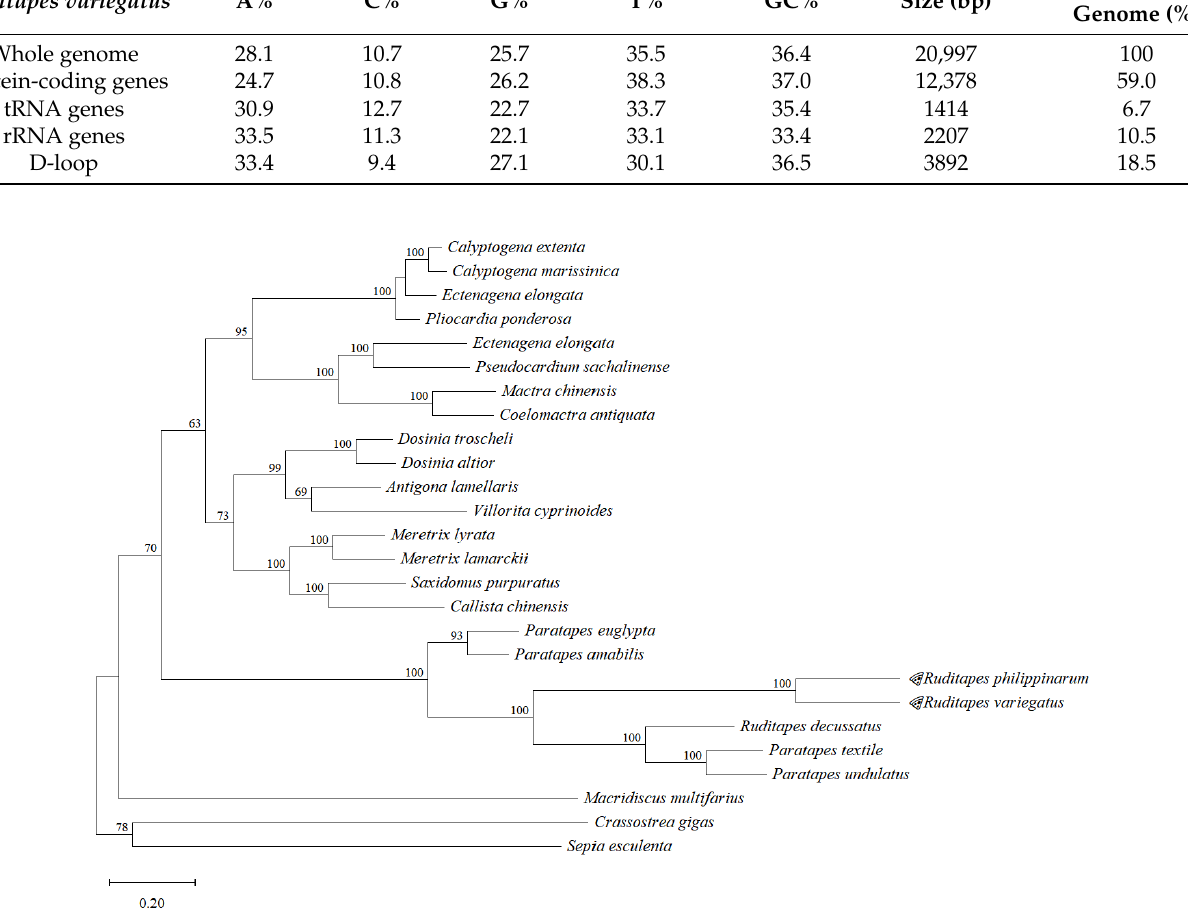
Figure 5. Maximum-likelihood phylogenetic tree constructed for Ruditapes philippinarum and R. variegatus .